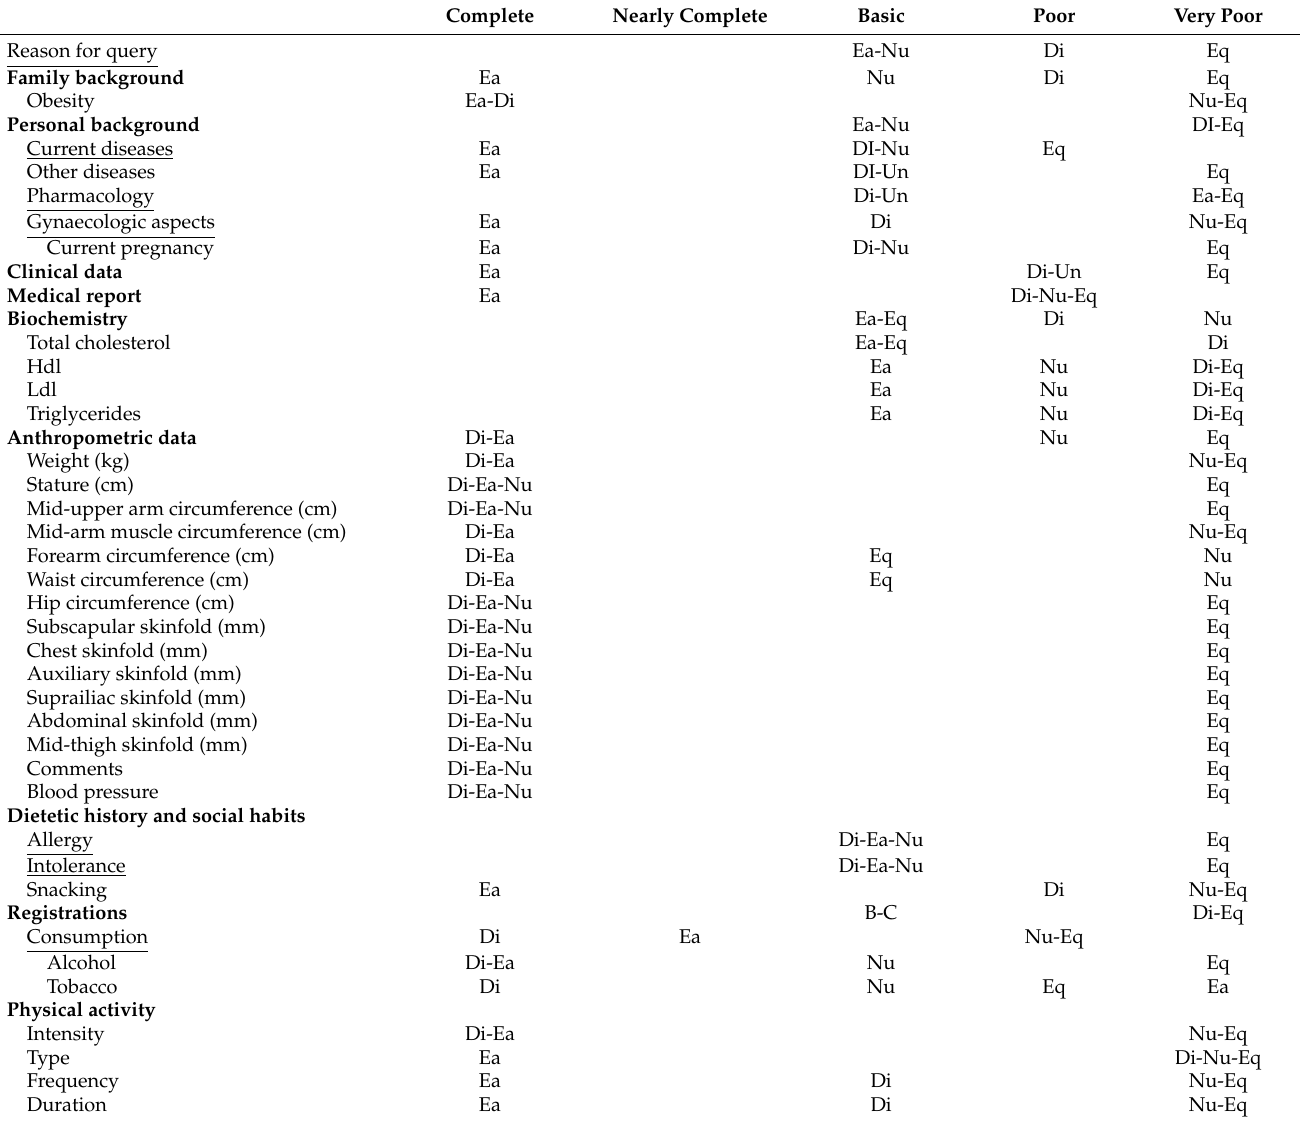
Table 2. Coverage of the coinciding variables of nutritional assessment of the records of the software analysed with respect to the ADA